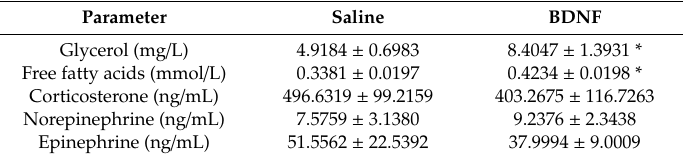
Table 1. Plasma levels of glycerol, free fatty acids, corticosterone, epinephrine, and norepinephrine following intracerebroventricular injection of saline or brain-derived neurotrophic factor (BDNF). Blood samples were collected 6 hours after treatment. n = 10 per group. Values are represented as mean ± SEM. * Represents significant di ff erences relative to saline-treated rats ( p <